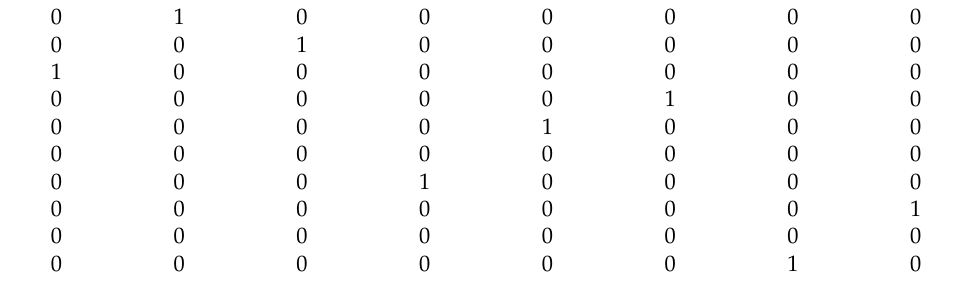
Table 6. Matrix of the best